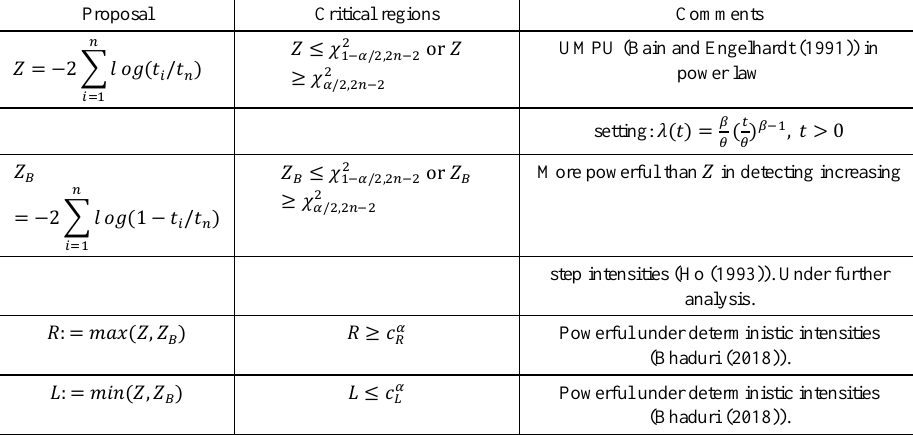
Table 3. Test statistic proposals for multiple testing (Bhaduri (2018) [2]). Proposal Critical regions